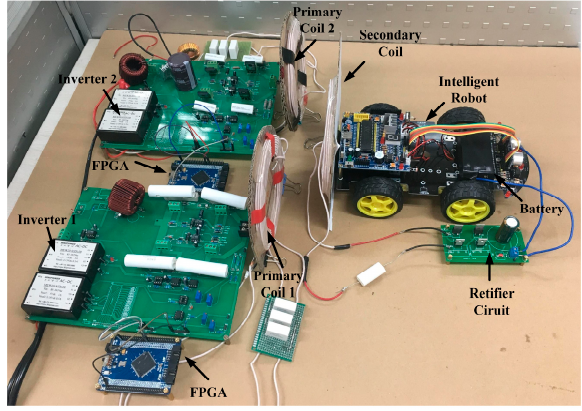
Figure 11. Experimental set-up.